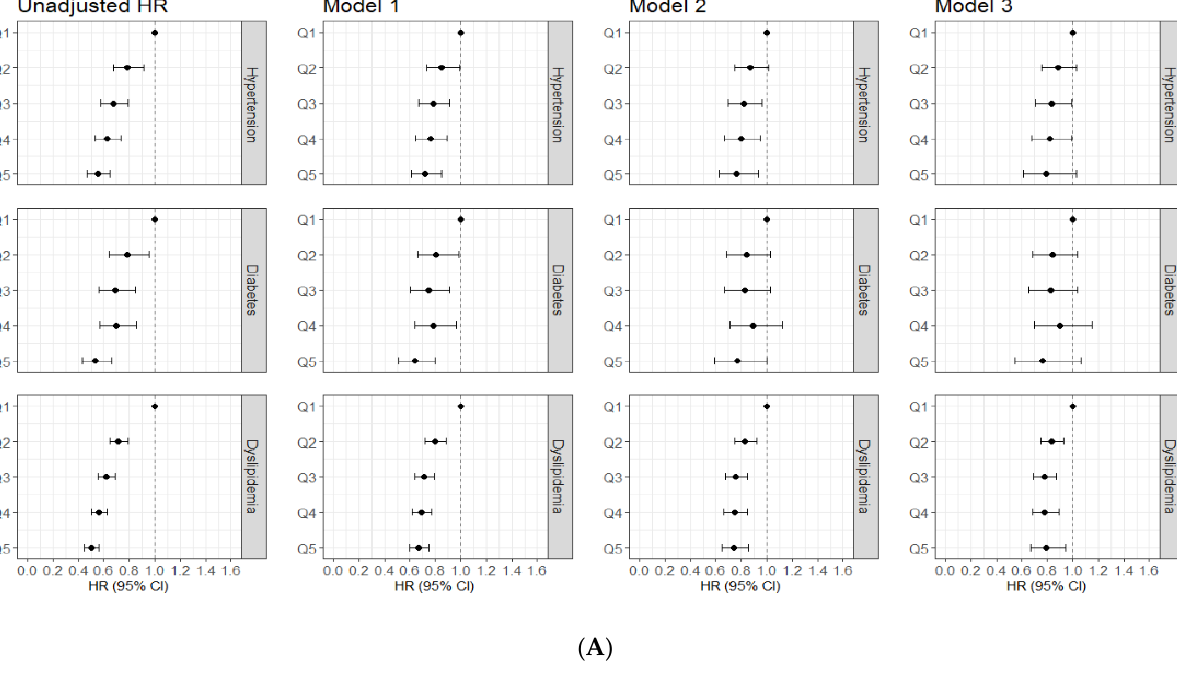
( B ) Figure 3. Association between dietary fiber intake and all-cause mortality and cardiovascular disease mortality according to hypertension, diabetes, and dyslipidemia. ( A ) All-cause mortality, ( B ) Cardiovascular disease mortality. HR: hazard ratio; CI: confidence interval 4. Discussion In this study, we found that DF intake was significantly inversely associated with all- cause mortality and with CVD mortality in middle-aged and older Korean adults. Poor dietary habits are associated with many chronic diseases and can be a major contributor to mortality [18]. In contrast, a healthy diet is one of the most promising factors in primary and secondary prevention of NCD [19]. DF, “the seventh nutrient” of the body, is a component of fruits, vegetables, and whole grains, and is non-replaceable to maintain health [20]. DF has anti-inflammatory [10] and antioxidative properties [21] and has been shown to lower blood pressure [7], reduce serum cholesterol [22] and glucose levels [9],